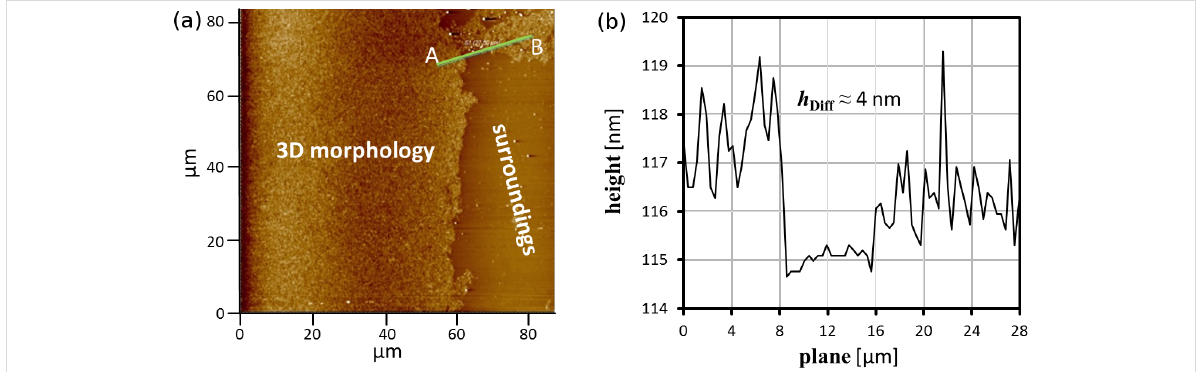
Figure 5: (a) AFM images of a PPDL-D4 LB layer transferred onto mica at 0.5 mN·m − 1 . (b) Height diagram of the cross-section trace along the green line starting from A, ending at B where h Diff is the height difference.